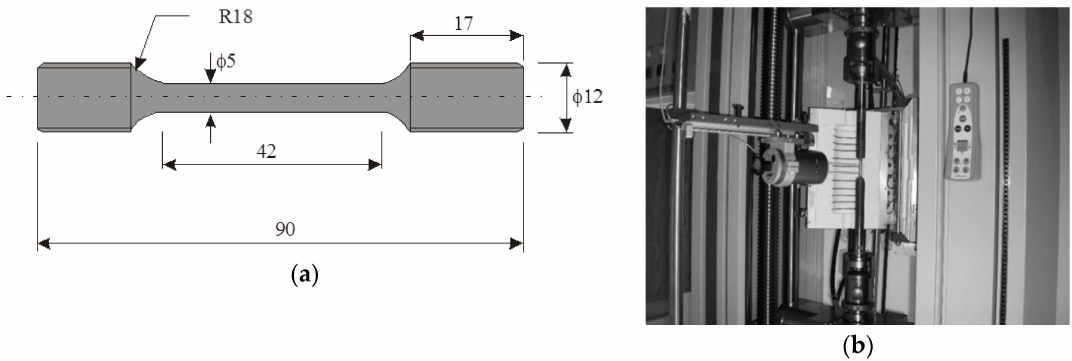
Figure 1. ( a ) Test specimen (dimension in mm); ( b ) testing machine.